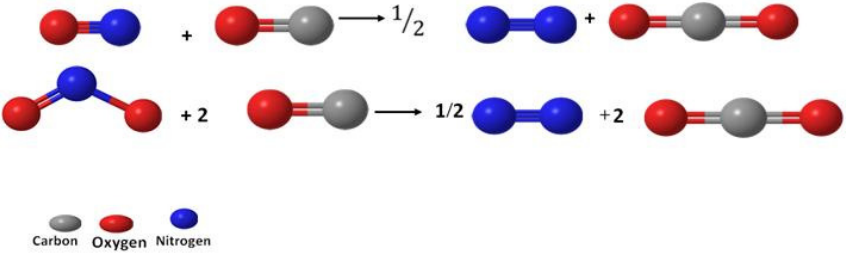
Figure A1. Schematic representation of the reactions that occur during CO-SCR reaction.